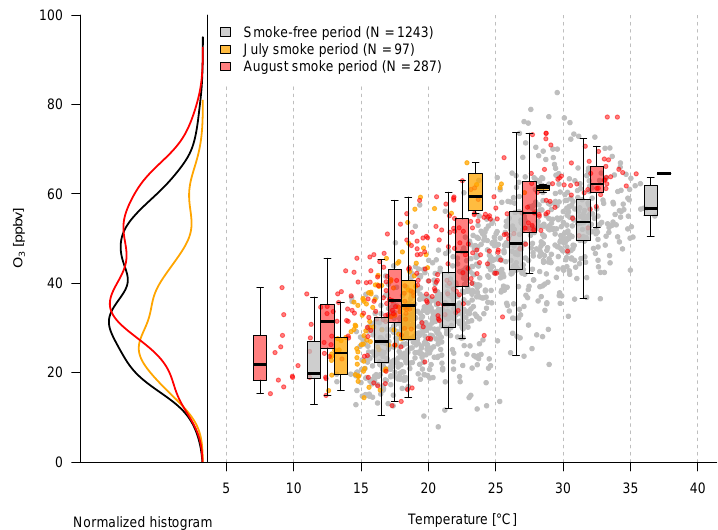
Figure 6. Hourly O 3 data from BAO plotted against hourly temperature data show a positive correlation between temperature and O 3 abundances for the smoke-free time periods in gray and both smoke-impacted periods (July in orange and August in red). Overlaid are box plots (5th, 25th, 50th, 75th, and 95th percentiles) for each 5 ◦ C bin. On the left normalized histograms of the hourly O 3 data are plotted, with all smoke-free measurements in black, and all hourly measurements made during the July smoke-impacted period in orange, and August smoke-impacted period in